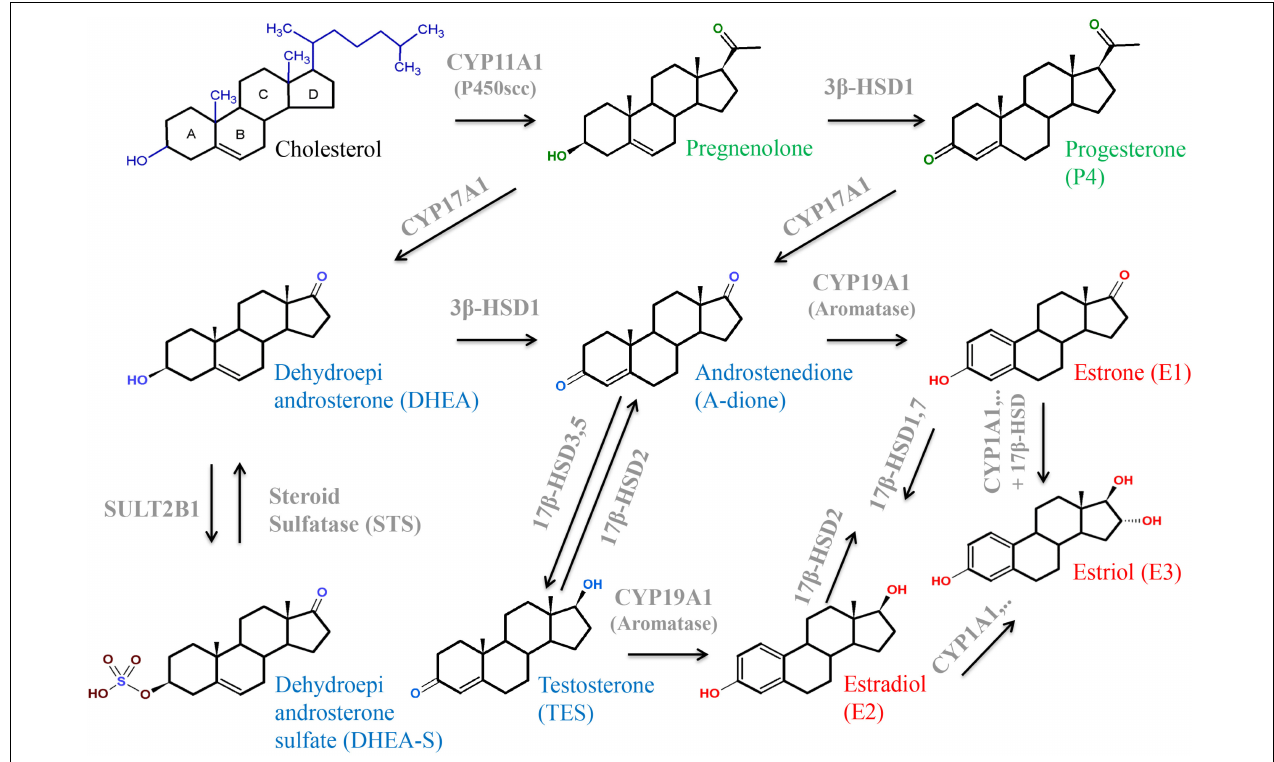
FIGURE 5 | Structures and interconversion of the sex-steroids progestagens (green), estrogens (red), and androgens (blue) starting from cholesterol. For detailed information, see text. Arrows indicate metabolizing processes by respective enzymes (gray). CYPs, cytochrome P-450 enzymes; HSD, hydroxysteroid dehydrogenase; SULT,